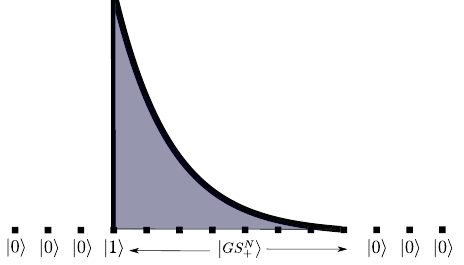
FIG. 4. Sketch of a superspin. For positive values of s , the ground state is exponentially localized near the first occupied spin. The empty sites on the left of j 1 i are not dynamical. If we complete the state with j 0 i ’ s on the right, we obtain a good approximation of the ground state of the Hamiltonian (1) in the thermodynamic